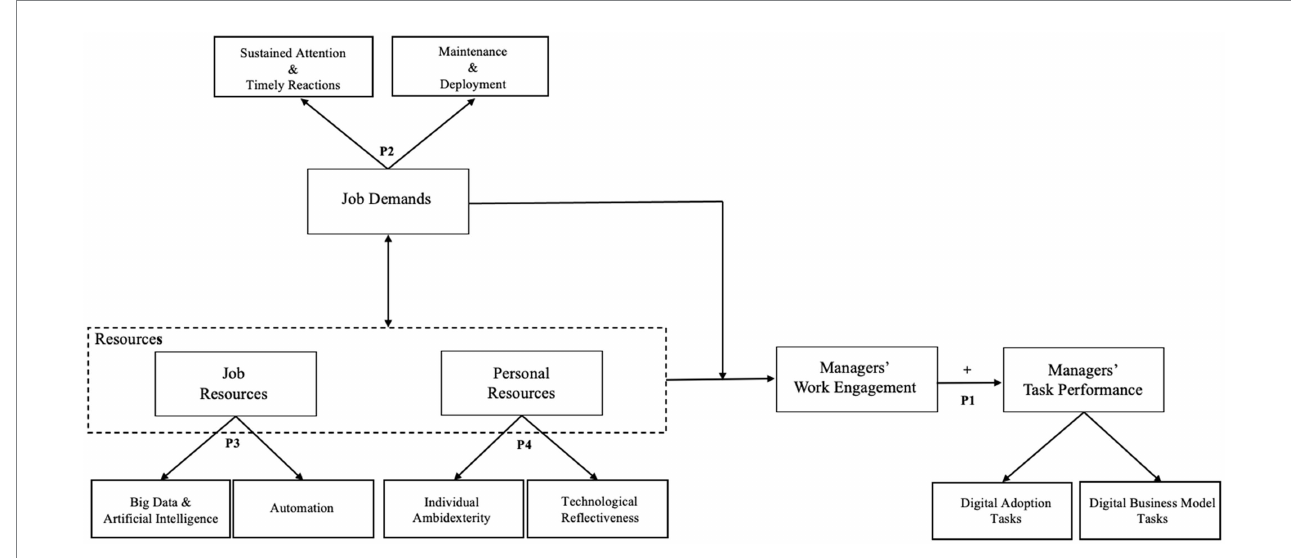
FIGURE 1 A managers’ work engagement framework for understanding digital managerial tasks. Adapted from Bakker and Demerouti